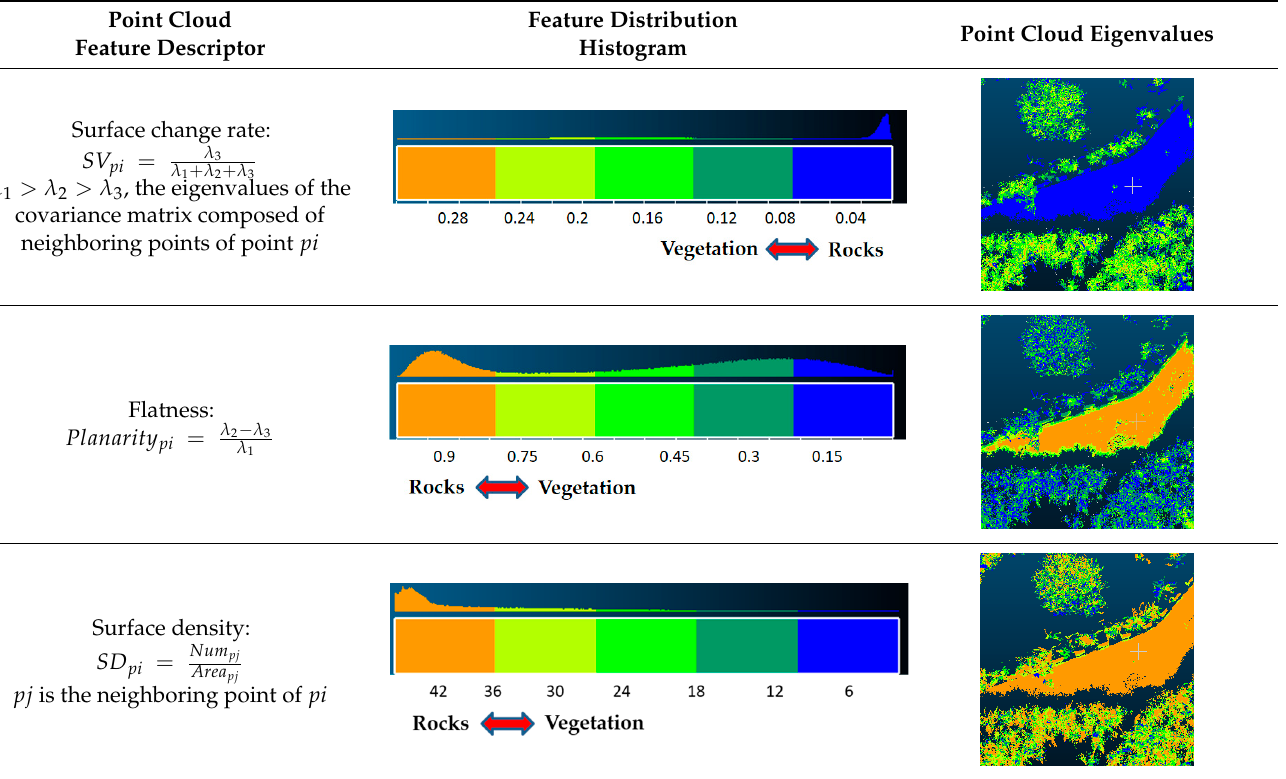
Table 1. Point cloud feature description of several rock masses and vegetation.